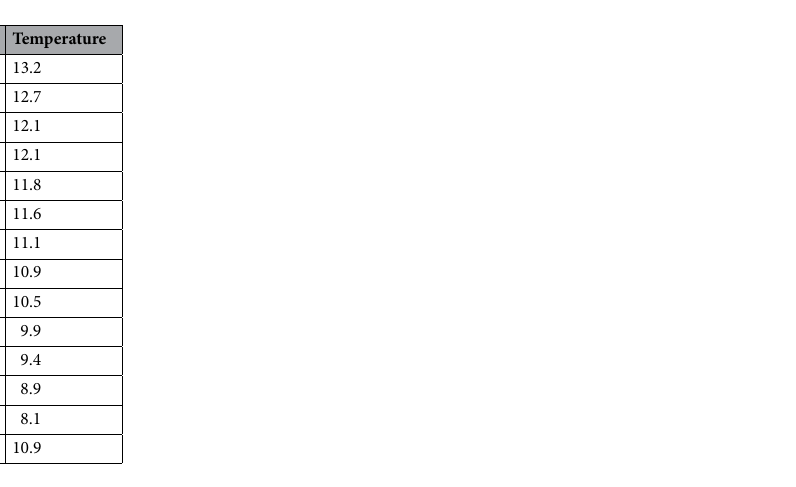
Table 3. Sample size, elevations and temperatures of 13 sampling sites where yellow-legged hornets ( Vespa velutina nigrithorax ) were collected. Avg. temperature indicates the average annual temperature in 2020 at the sites, measured by the National Park Office of Jiri